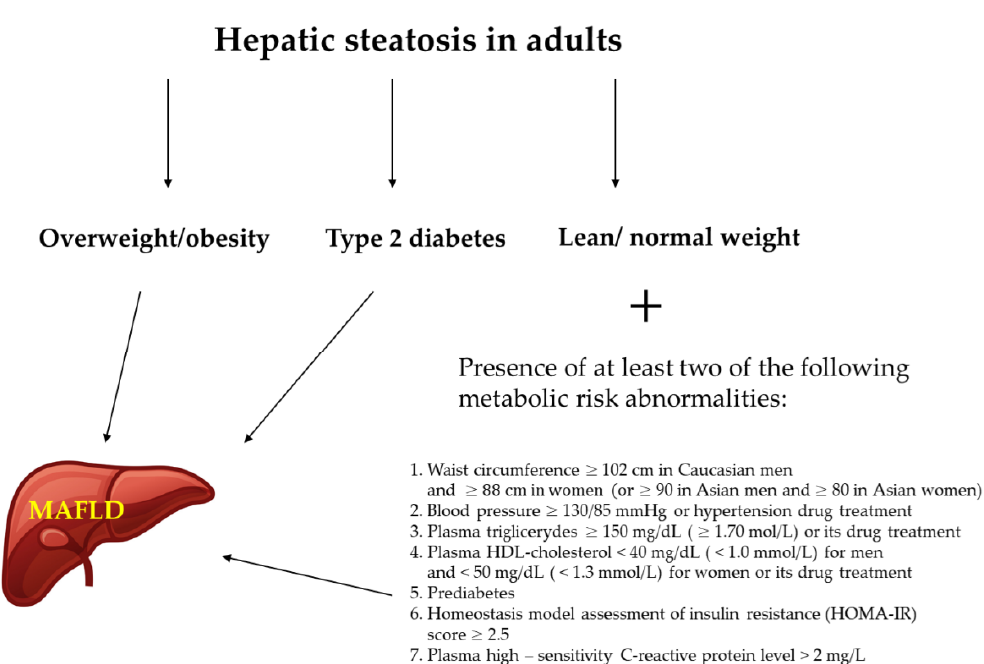
Figure 2. Diagnostic criteria for MAFLD (metabolic dysfunction–associated fatty liver disease) [12].